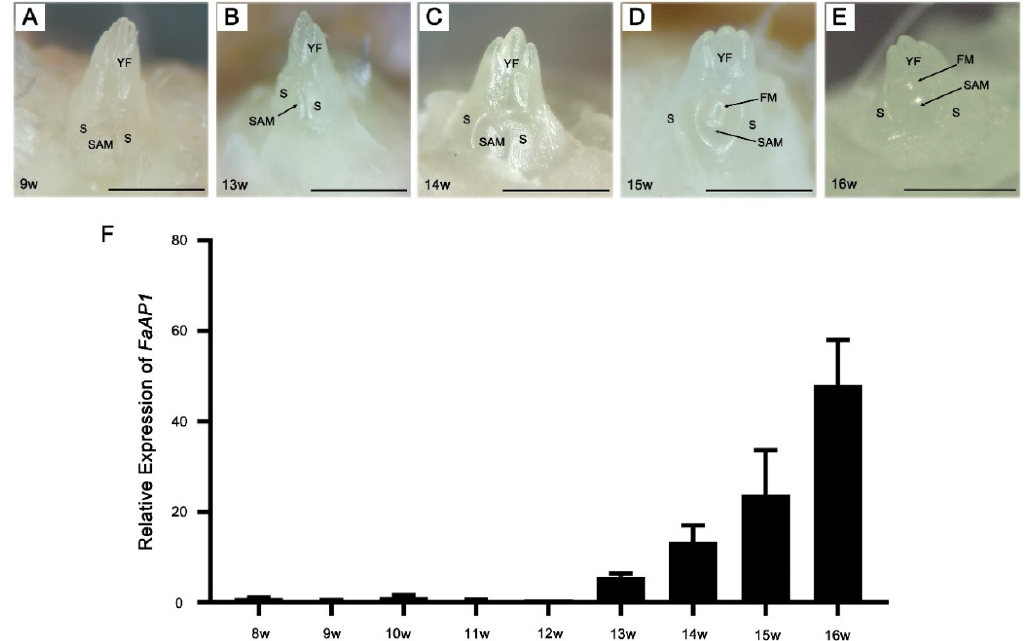
Figure 1. Overview of floral induction in strawberry ‘Benihoppe.’ ( A – E ) Morphological observation of the shoot apices at different time points during the induction of flower in strawberry. The observation results of 9 w, 13 w, 14 w, 15 w, and 16 w are shown ( A – E ). SAM, shoot apical meristem; S, Stipule; YF, young leaf; FM, flower meristem. Scale bar = 1 mm. (F) QRT-PCR analysis of the expression of the flowering marker gene FaAP1 from 8 w to 16 w. Data are displayed as averages ± SD of three biological repeats.